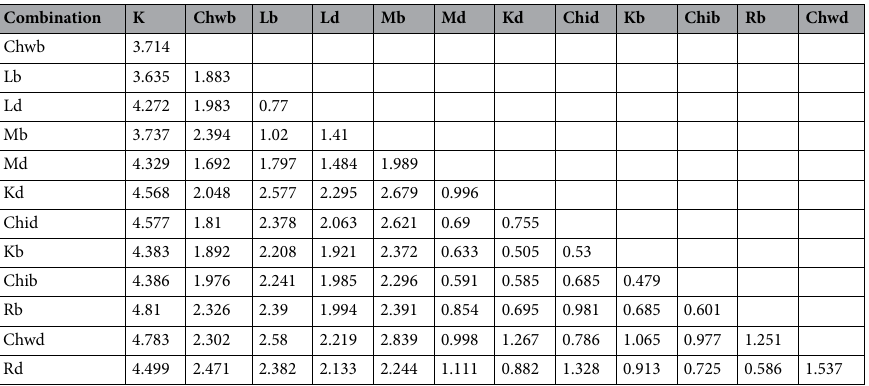
Table 5. Mahalanobis distances between combinations of herbicides and application methods calculated on the basis of all seven traits. Combinations: K – trees without any treatment, Kd – trees with drilling, Kb – trees with bark incision as well as five different herbicides: Chi – Chikara, Chw – Chwastox, L – Logo, M – Mustang, R – Roundup and two methods of their application: d – drilling or b – incision.